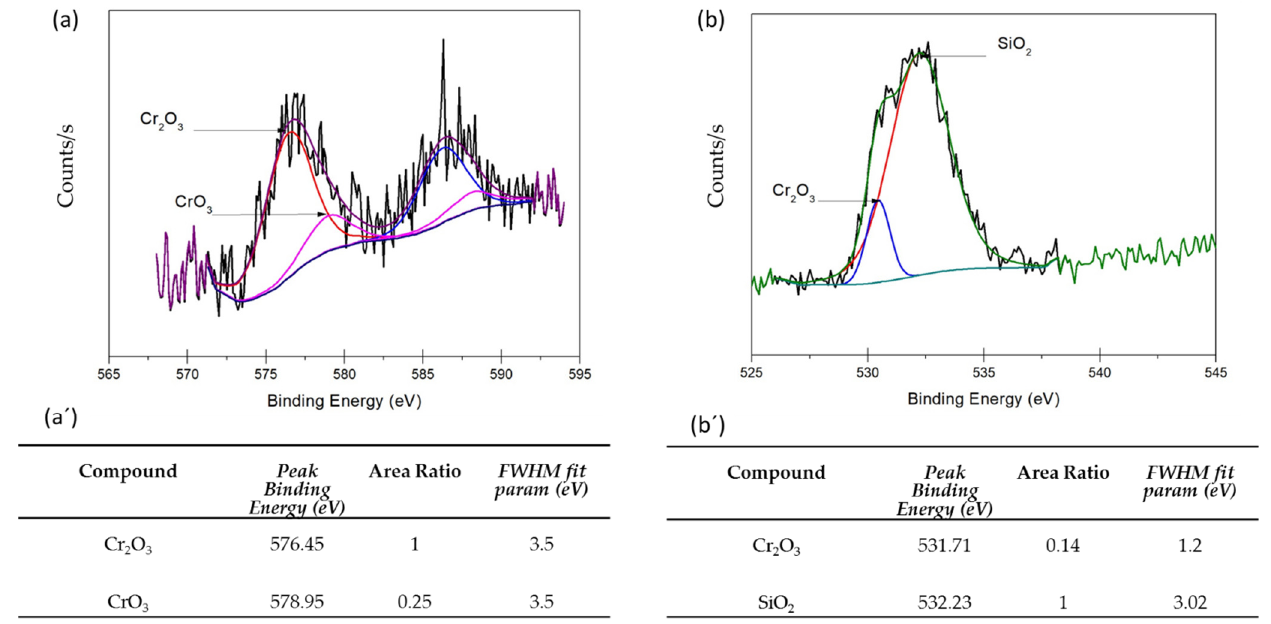
Figure 7. X-ray photoelectron spectra for CUSTOM 450CA–50 min–49 °C: ( a ) Cr 2p, ( b ) O 1s. Parameters obtained: peak binding energy and FWHM fit param ( a’ ) Cr 2p, ( b’ ) O 1s.